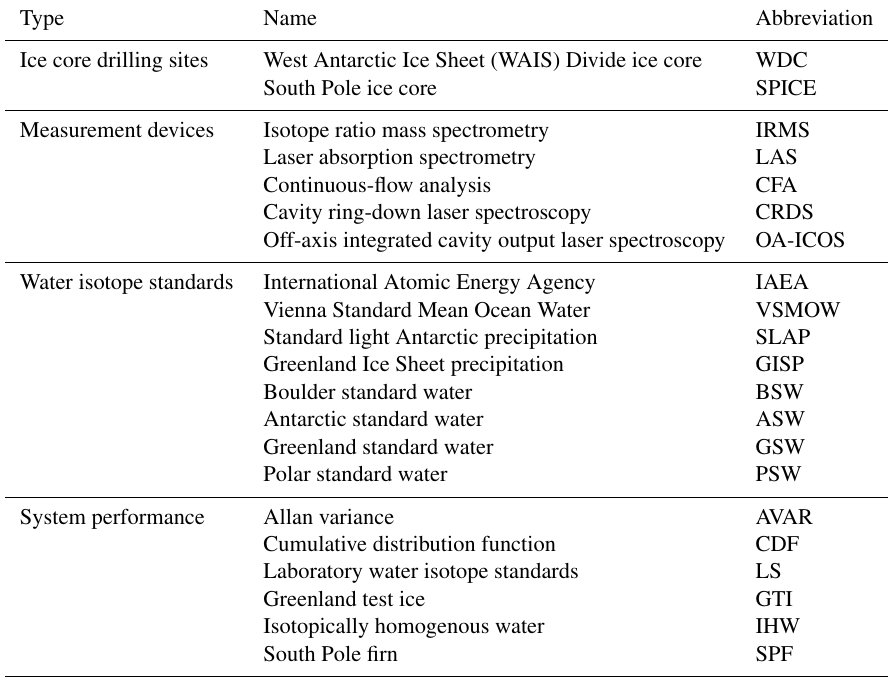
Table 1. List of abbreviations used in this